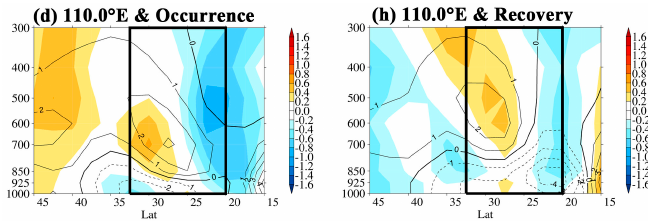
Figure 1. Vertical cross-sections of composited meridional or zonal water vapor transport (WVT) at drought: ( a – d ) occurrence; and ( e – h ) recovery at boundaries of Southwest China (SWC). The contours represent WVT, for which the unit is 10 − 1 ·kg·m − 1 ·s − 1 ·hPa − 1 . Standardized anomalies (SA) are shown by shadows, whereas warm and cold colors indicate inflow and outflow, respectively. The bold black box indicates the area over SWC. The black shadow areas in ( b , c , f , g ) represent the Qinghai–Tibet Plateau.